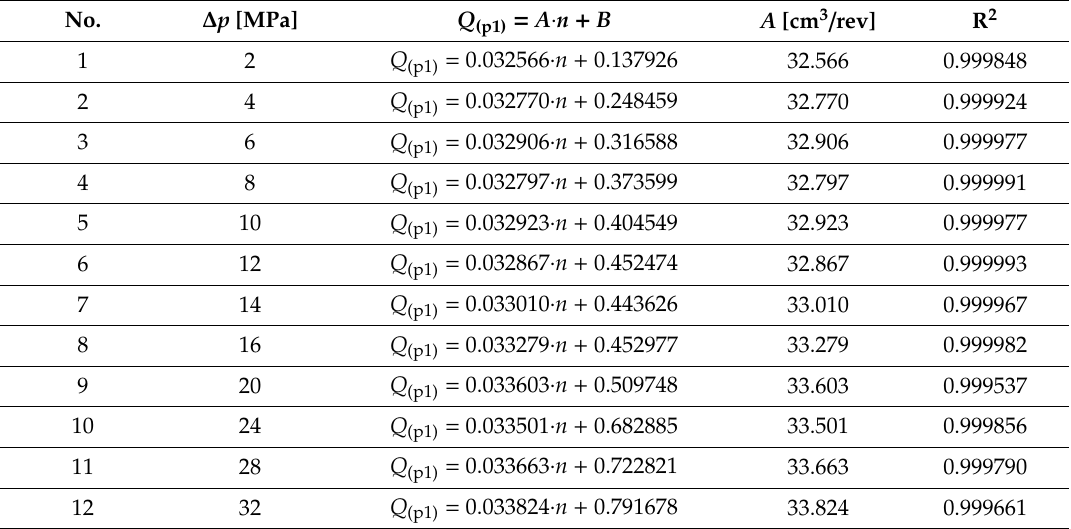
Table A5. Equations Q (p1) = A · n + B of motor output flow rate at ∆ p = const. (Balawender’s metod).